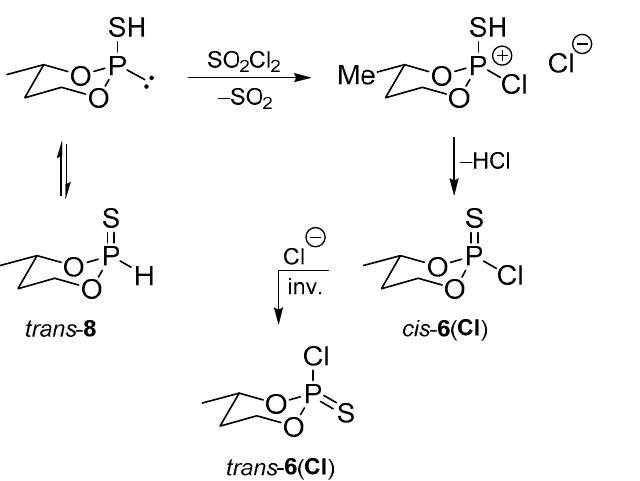
Scheme 5. Proposed pathway of conversion of thiophosphite trans - 8 into thiophosphoryl chloride trans - 6 ( Cl ).